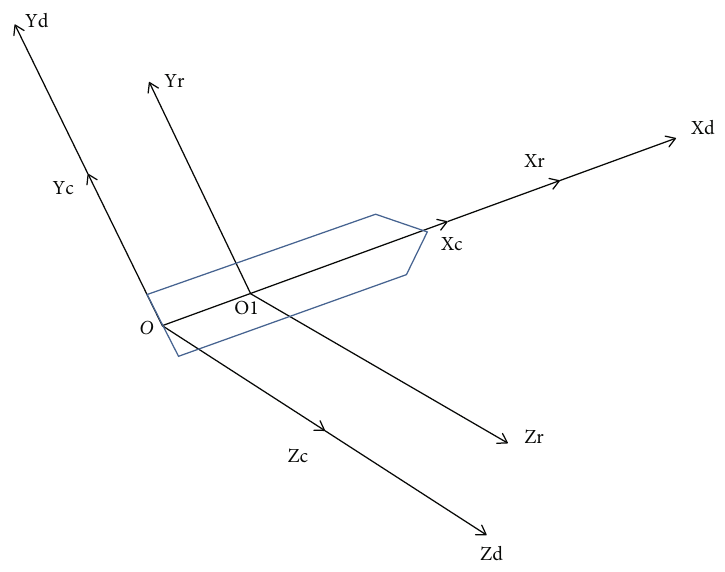
Figure 1: Sensors installation